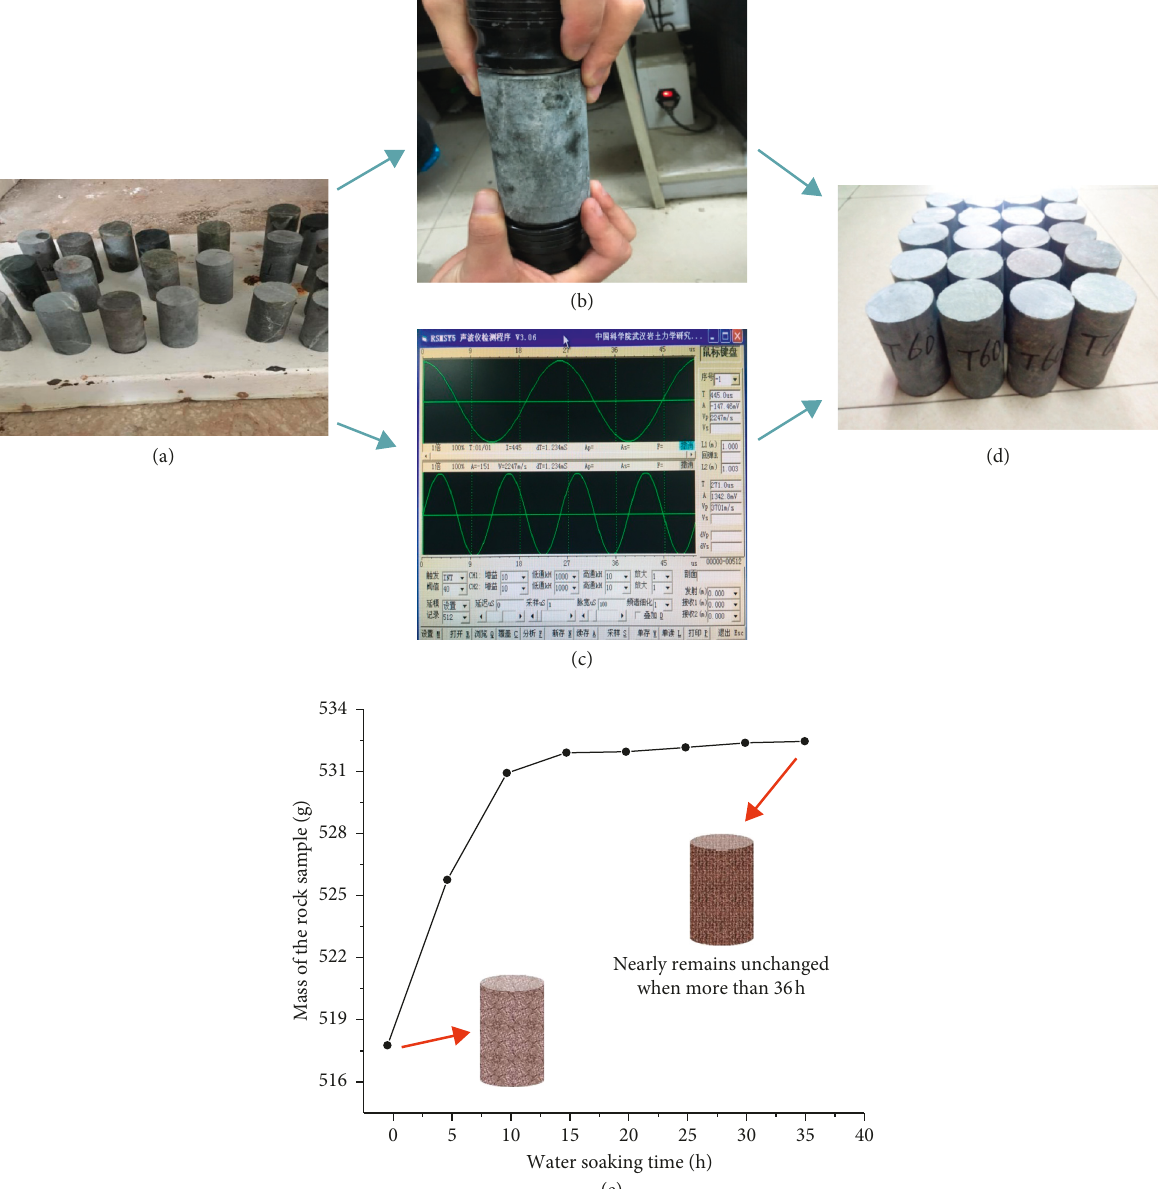
Figure 2: The process of sample screening: (a) cylindrical samples; (b) wave velocity induction transducer; (c) wave velocity test interface; (d) some screened samples; (e) variation of sample mass with soaking time in